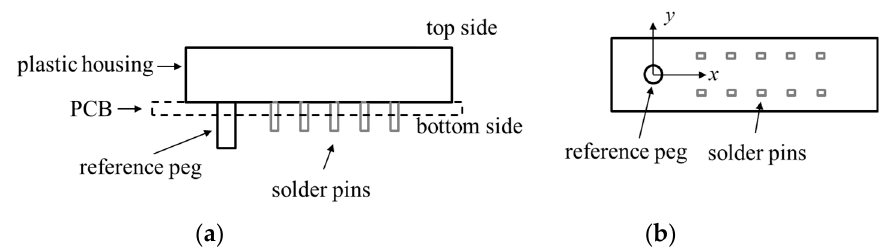
Figure 2. ( a ) The side view and ( b ) the bottom view of a typical through-hole connector.